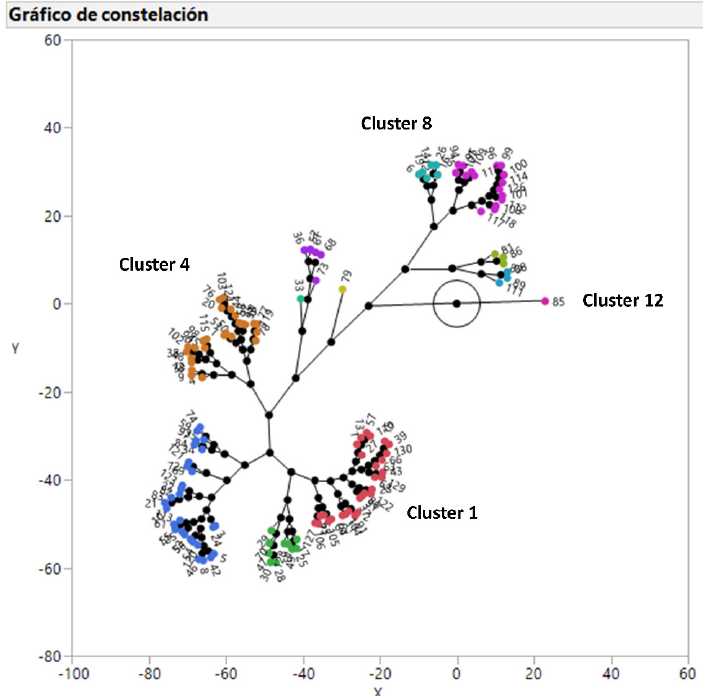
Figure 2. Constellation plot showing the results of 130 Pasteurella multocida isolates after a hierarchical clustering analysis of MIC values for the 10 antimicrobials tested. The numeration begins in cluster 1 and ends in cluster 12